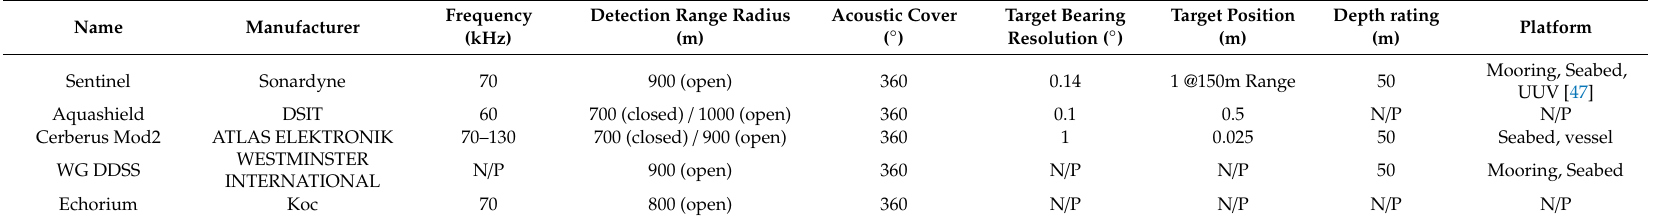
Table 11. Acoustic sensor: diver detection sonar (DDS).